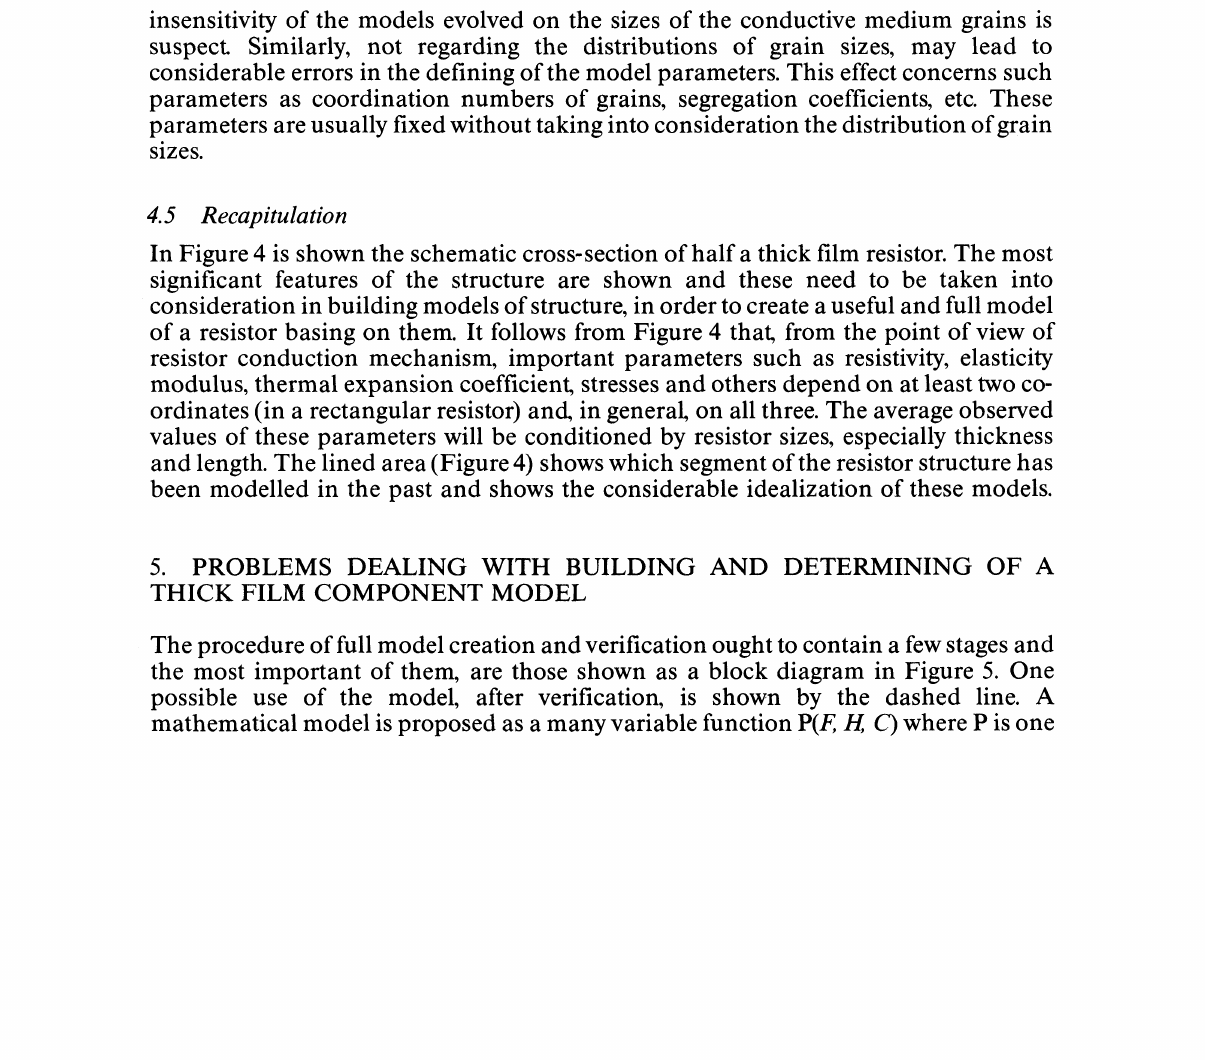
FIGURE 4 Schematic cross-section of half of a thick film resistor showing the most important components of the structure which influence electrical